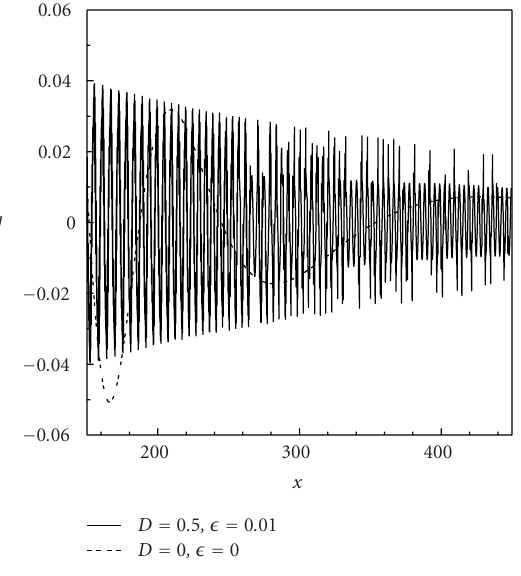
Figure 5.3. Wave motion due to impulse for fixed time t = 100; (cid:1) = 0 . 01, D = 0 . 5.